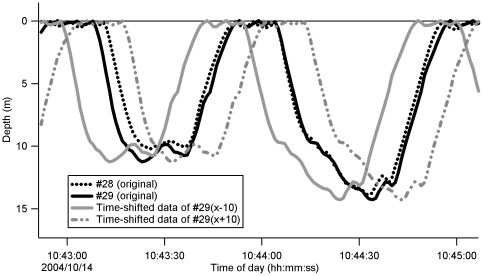
Example of time-shifted data for the swimming depth of a partner.Individual #28 was the reference individual and individual #29 was the partner.